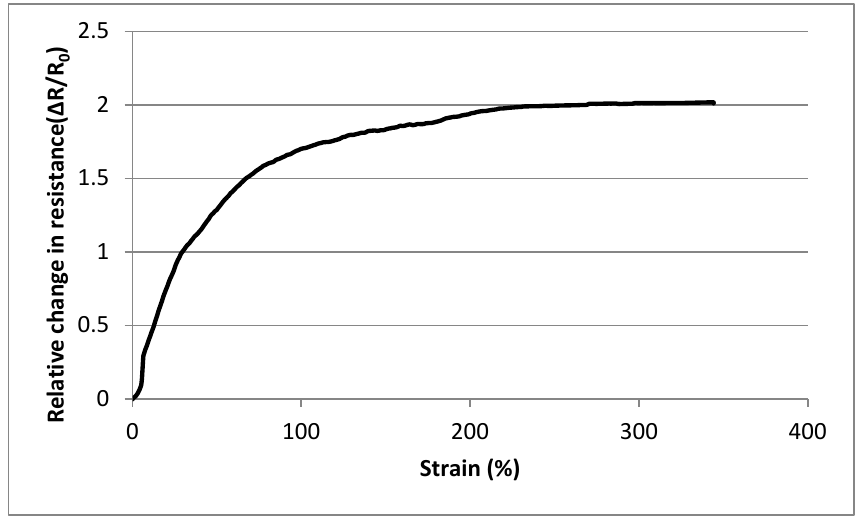
Figure 6. Resistance versus Strain up to breaking point of group 1 sample.